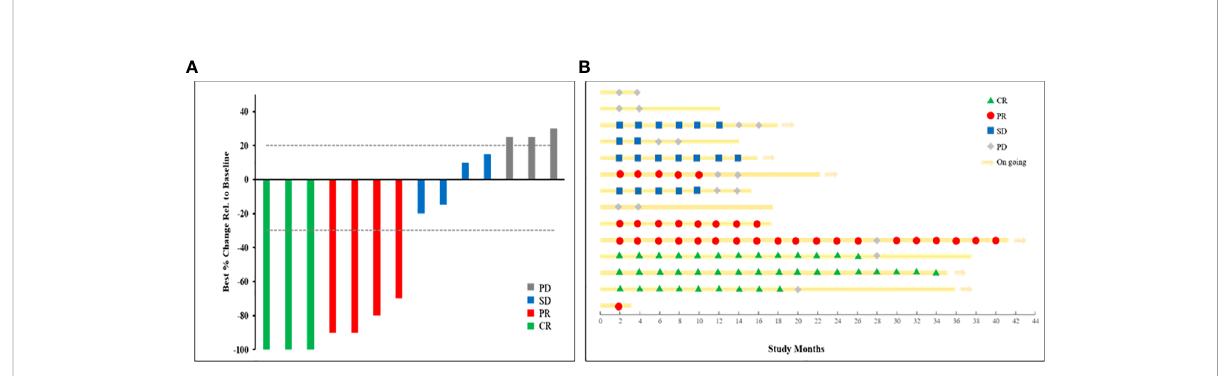
FIGURE 2 Treatment ef fi cacy for the study population. (A) Waterfall plot of radiographic responses. (B) Swimmer plot of response status over study time.